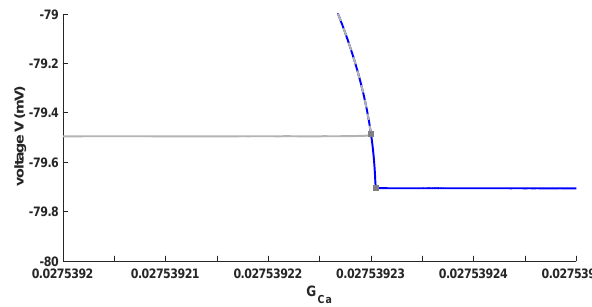
Figure 5. Refined view on Figure 4c at the transition of the first two limit cycle